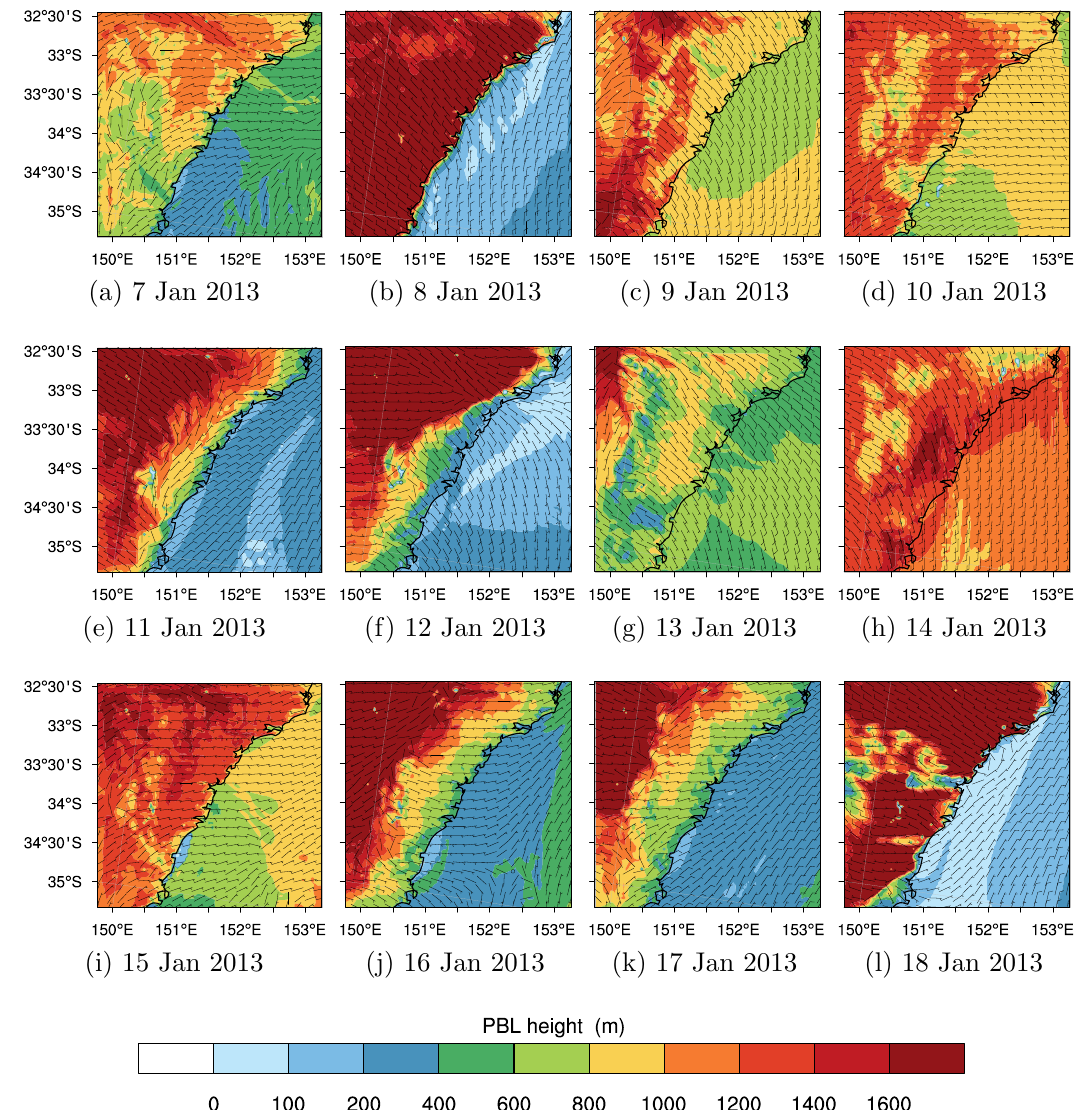
Figure 5. Map of simulated Planetary Boundary Layer (PBL) height (simulated by the Yonsei University (YSU) PBL scheme) from 7 January to 18 January 2013 at 3:00 p.m. local